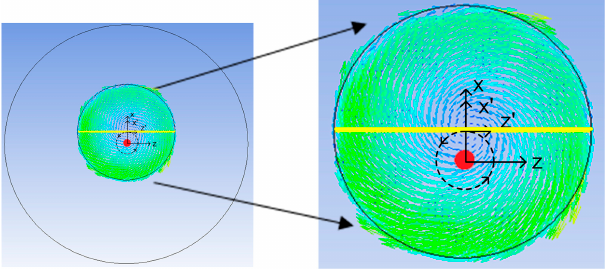
Figure 3. The average and maximum shear stresses in this work were all calculated along the yellow diameter which is perpendicular to the line connecting the origins of the global XYZ coordinate and the moving X ’ YZ ’ coordinate.